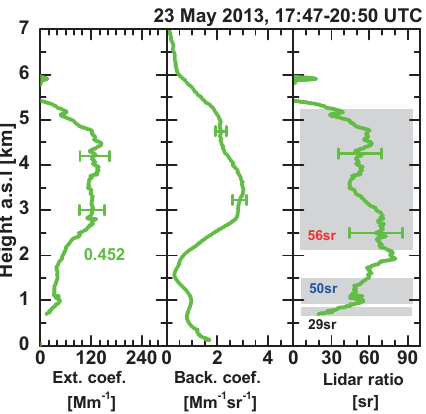
Figure 10. Mean vertical profiles of the 532nm particle extinc- tion coefficient, backscatter coefficient, and lidar ratio for the ob- servational period from 17:47–20:50UTC on 23 May 2013. The Raman lidar method is applied. Vertical signal smoothing lengths of 600m (below 1.1km height), 1500m (1.1–2.8km height), and 2100m (above 2.8km height) are applied before computing the ex- tinction coefficients and lidar ratios. The signal smoothing length is 750m for the shown backscatter coefficient profile. Total AOT (given as number in the left panel) and layer mean values of the lidar ratio for the 0.7–0.85km height layer (influenced by marine and local haze particles), the 0.86–1.5km layer (influenced by Eu- ropean haze) and for the pure dust layer (2.1–5.2km height range) are given as numbers. Error bars provide the uncertainty (standard deviation) by signal noise.